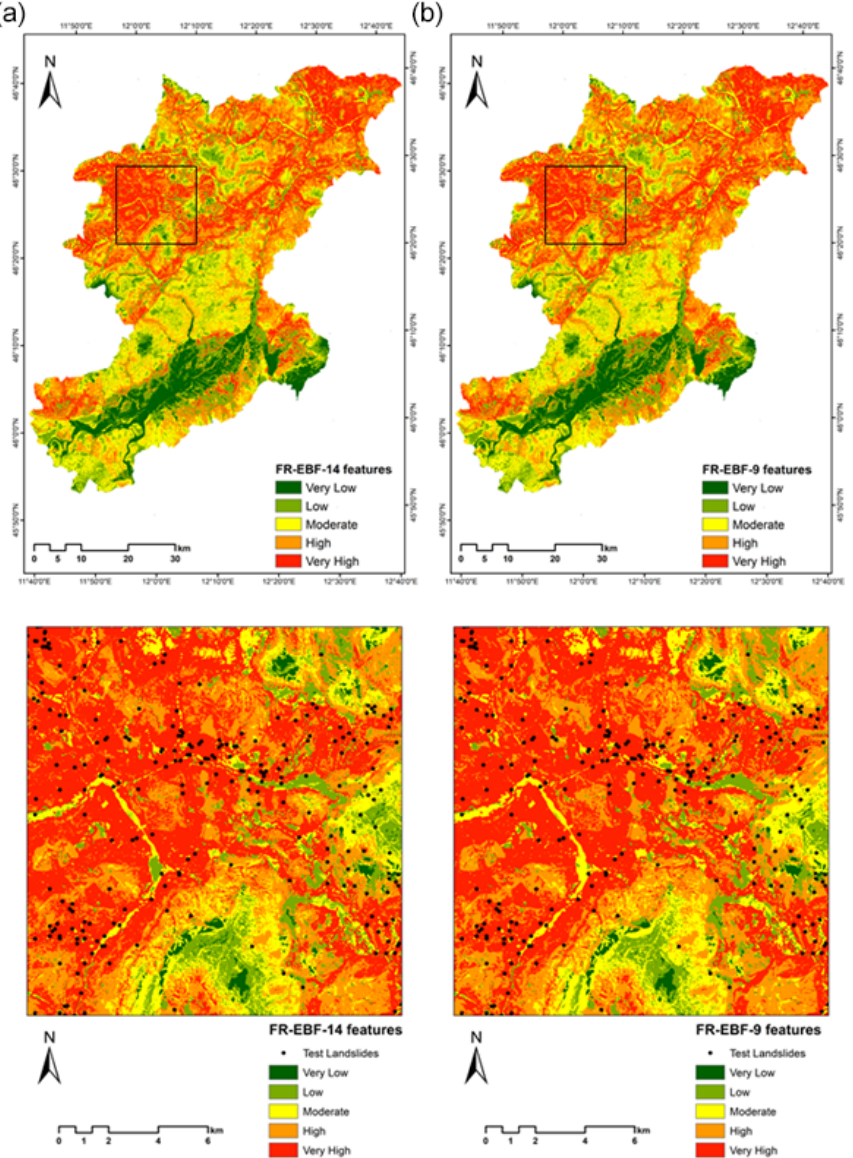
Figure 7. Landslide susceptibility maps derived using the ensemble of FR–EBF approaches for (a) 14 landslide features and (b) 9 landslide features (black square represents the enlarged